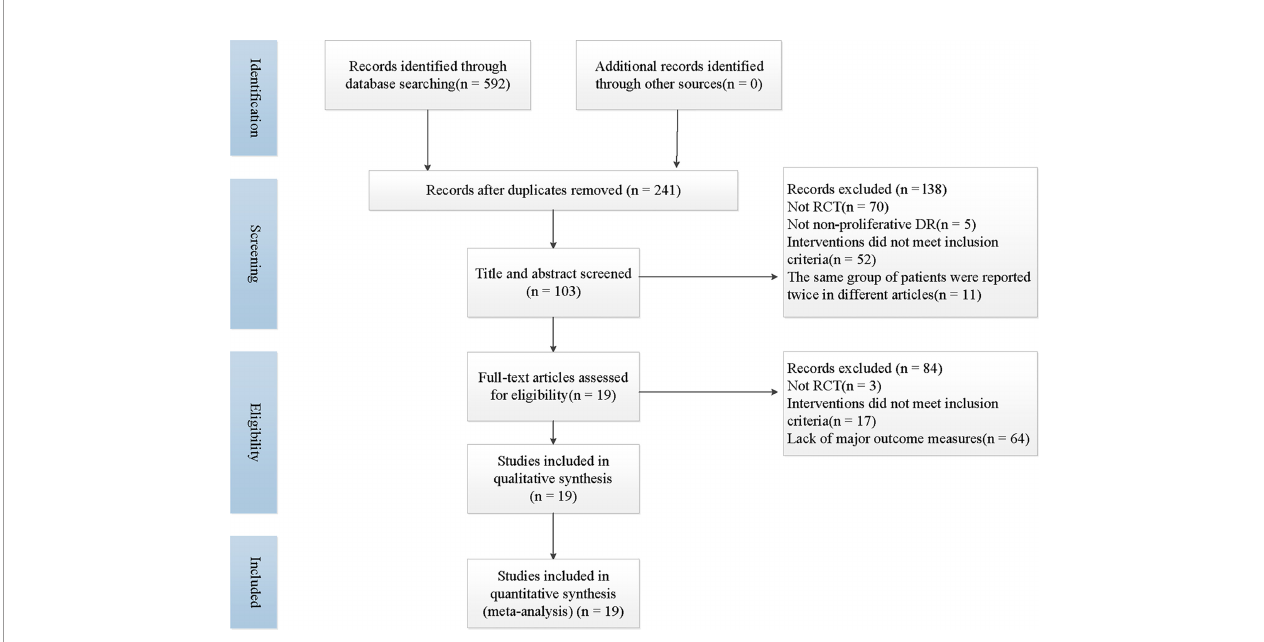
FIGURE 1 | The screening process summarized in a fl ow